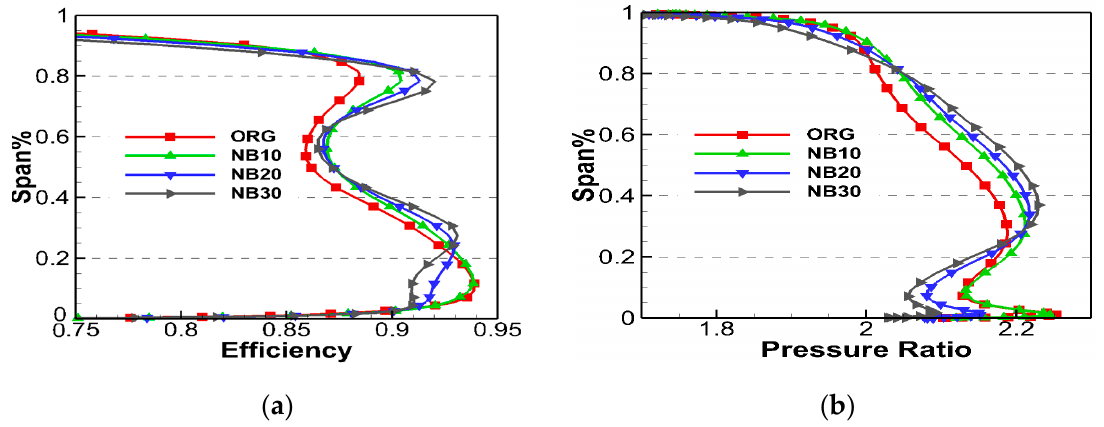
Figure 8. Comparison of the spanwise distribution of the total pressure ratio and the efficiency of NB10, NB20, and NB30. ( a ) the isentropic efficiency. ( b ) the total pressure ratio.